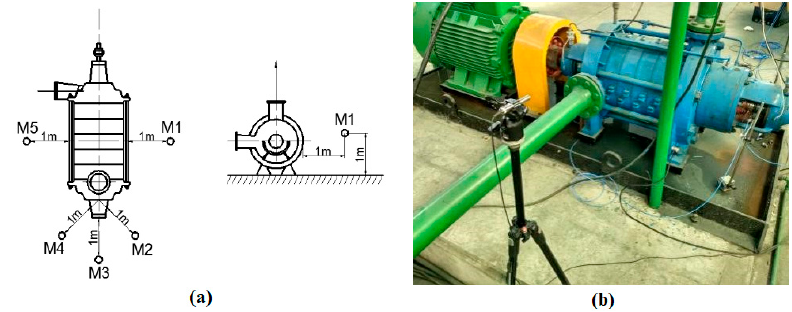
Figure 10. The ( a ) distribution of noise monitoring points and ( b ) noise experiment scene.